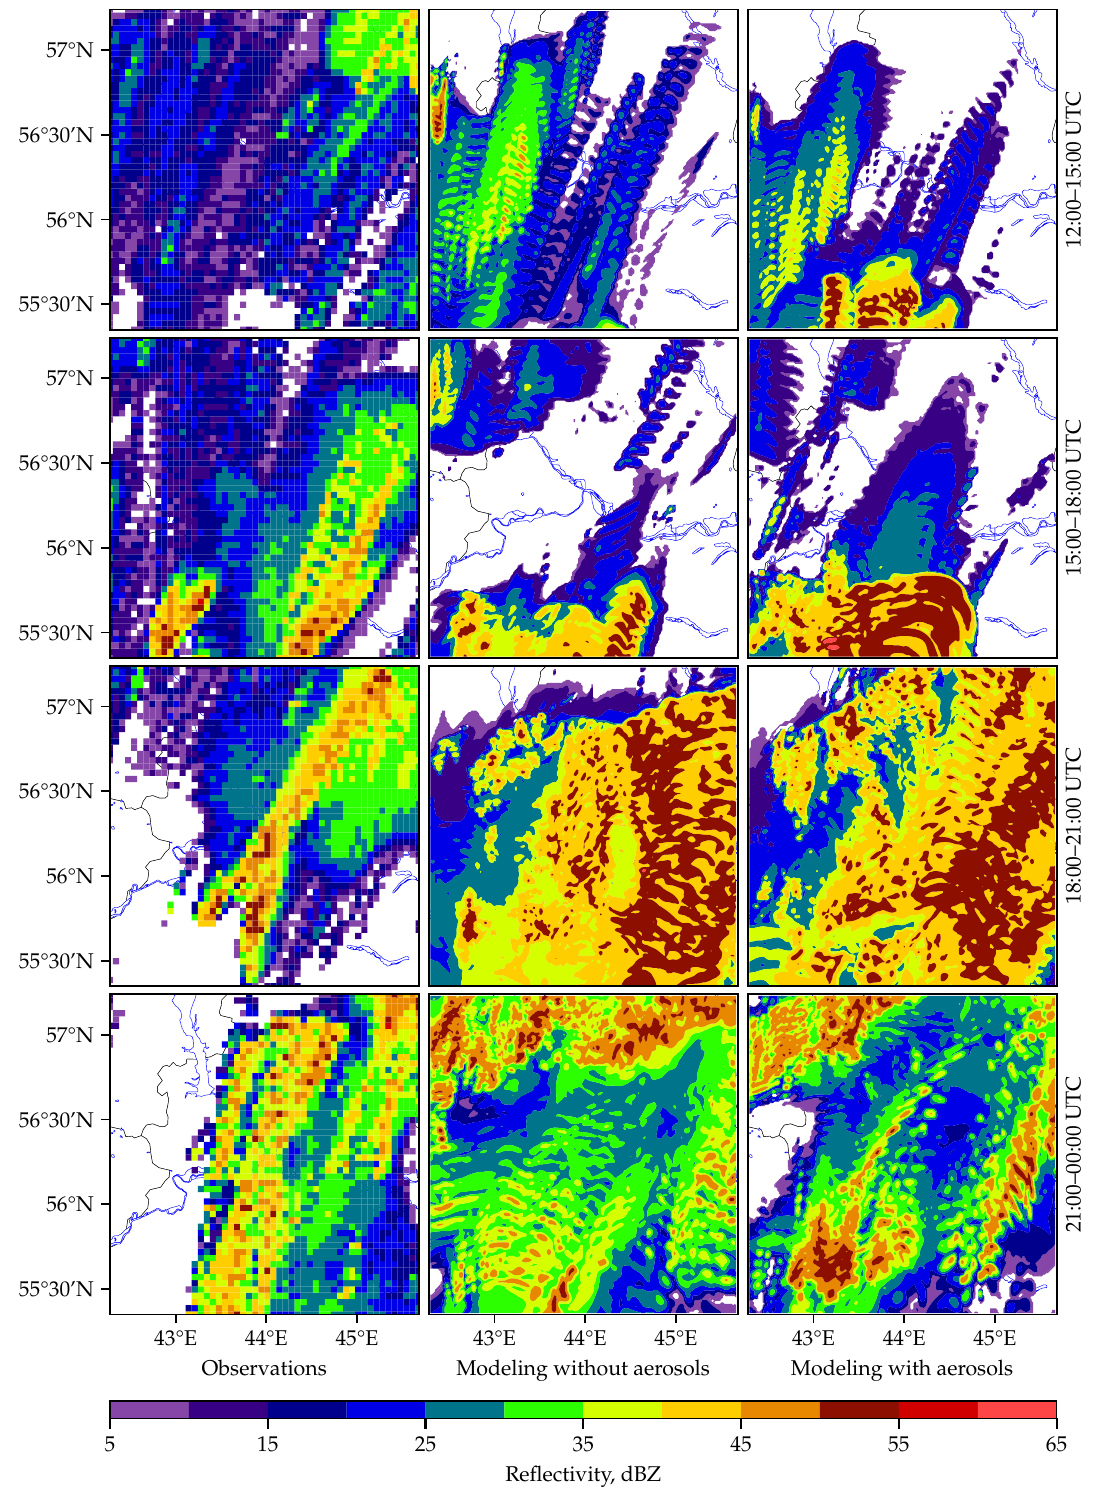
Figure 6. Maximum values of radar reflectivity at an altitude of 2 km at 3 h intervals for the thunderstorm in the Nizhny Novgorod region on 13–14 July 2020. Time series of the panels include 3-hour sets from 12:00 UTC 13.07.2020 (first row) to 00:00 14.07.2020 (last row) with a 3-hour step. Left column—DMRL-C observations, central and right columns—results of numerical simulation with non-aerosol and aerosol parametrizations of microphysics,